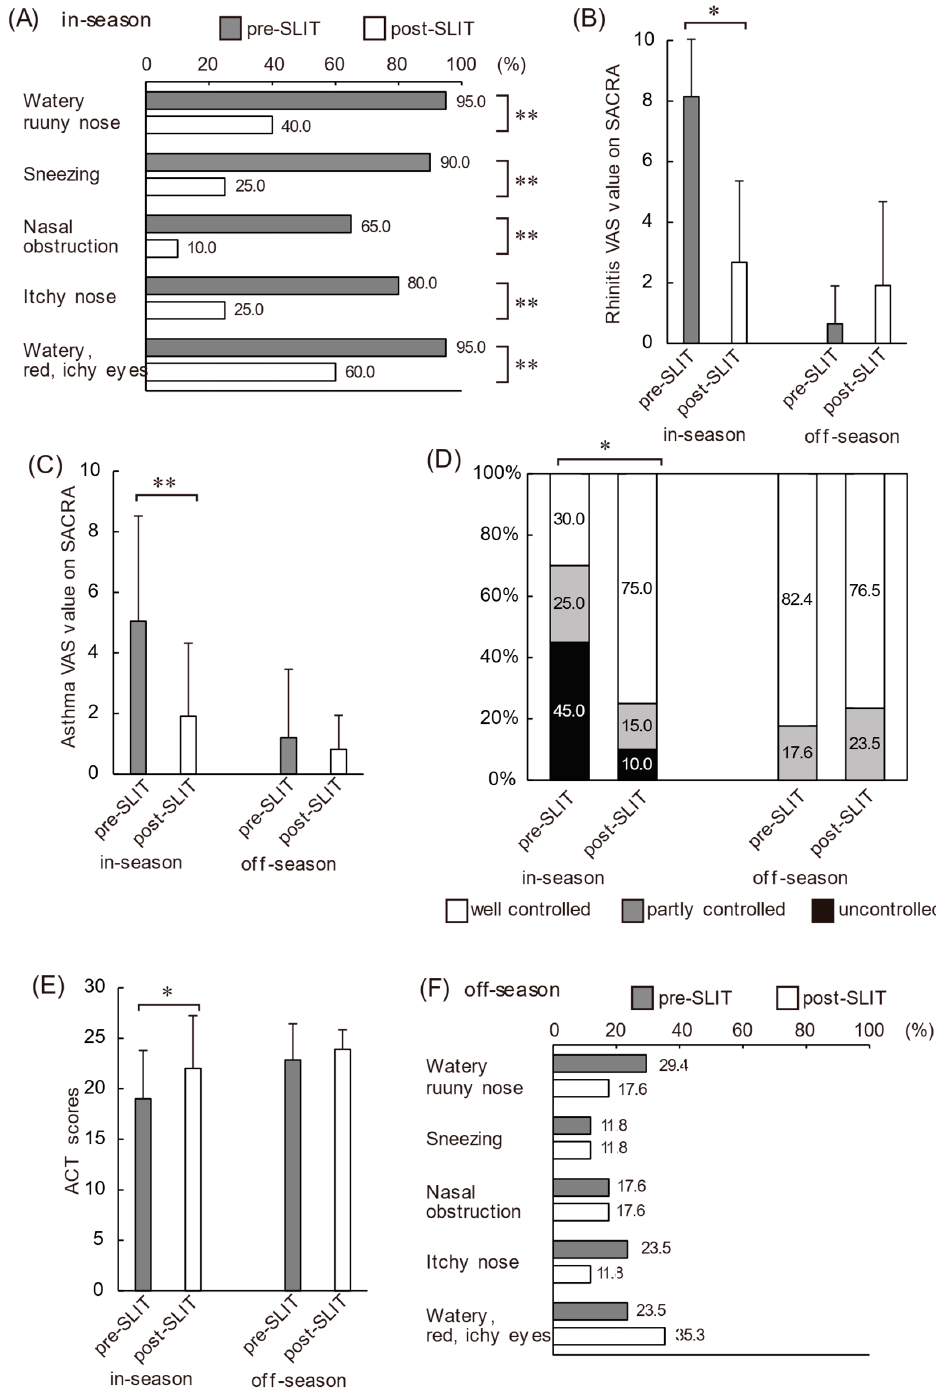
Figure 1. Changes in ACT and SACRA questionnaire scores during the in-season (February to April) and off-season (June to October) before and after SLIT. ( A ) Percentage of patients answering ‘yes’ to each question of the SACRA questionnaire about rhinitis symptoms before and after SLIT in-season ( n = 20). Rhinitis ( B ) and asthma ( C ) control levels measured by VAS before and after SLIT. ( D ) Proportion of patients with asthma control based on SACRA surveys. ( E ) Asthma control level measured by ACT before and after SLIT. ( F ) Percentage of patients answering ‘yes’ to each question of the SACRA questionnaire about rhinitis symptoms before and after SLIT during the off-season ( n = 17). Data are presented as the mean ± SD. * p < 0.05, ** p < 0.001. Abbreviations: ACT, asthma control test; SACRA, self-assessment of allergic rhinitis and